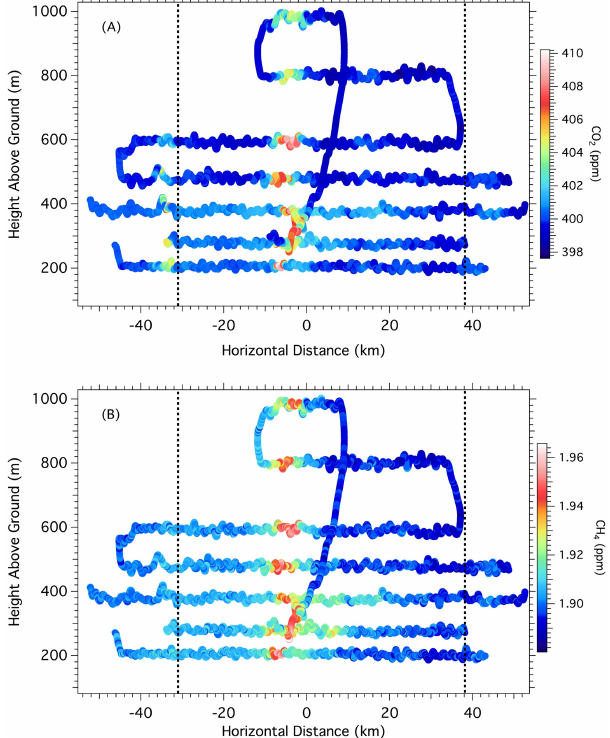
Figure 6. (a) CO 2 and (b) CH 4 observations on 29 April 2011 as a function of altitude and horizontal distance along the seven tran- sects. Broken lines represent the projected city limits. CBL depth was